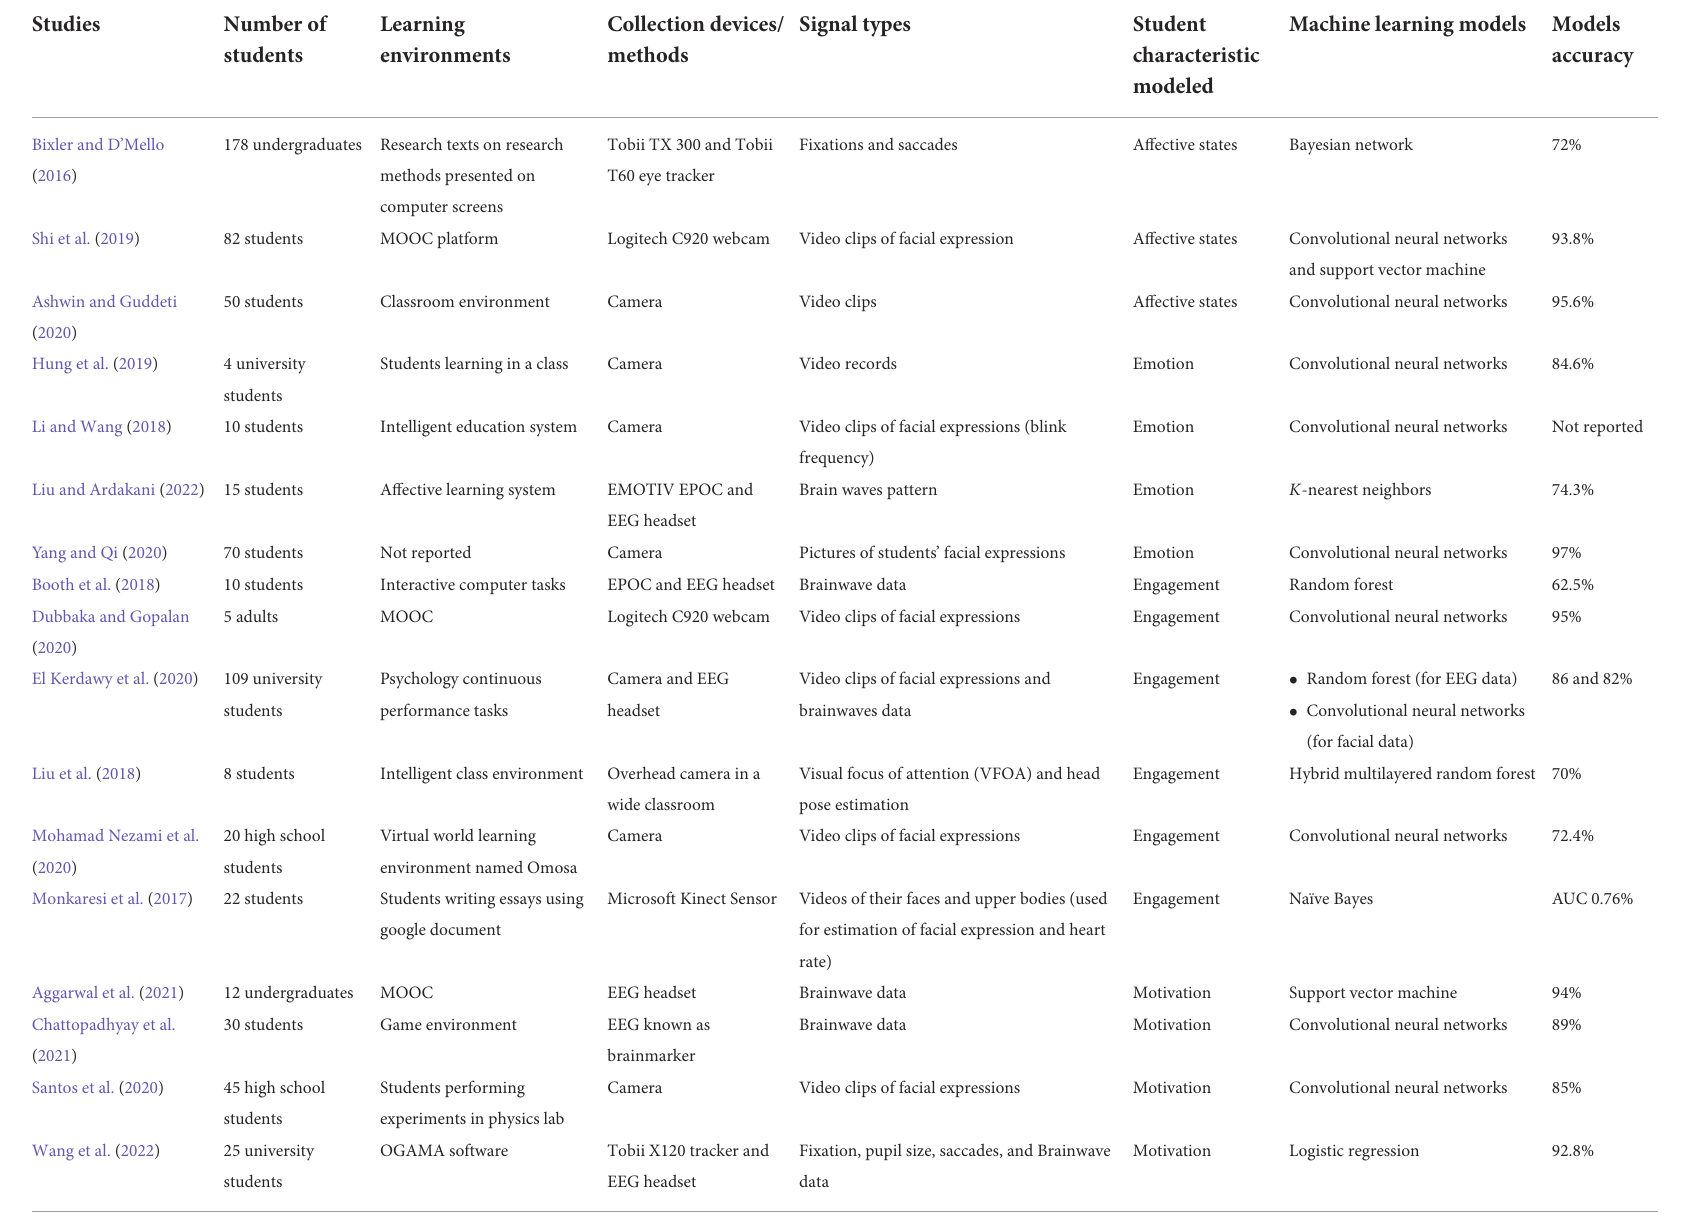
TABLE 2 Automatic modeling of student characteristics in learning studies using physiological